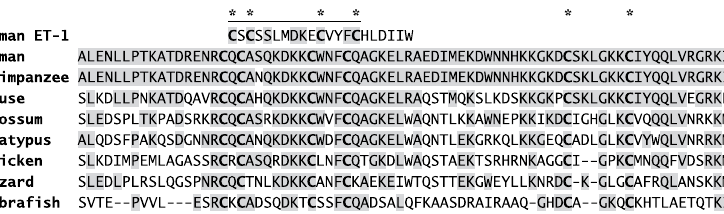
Figure 6. Inter species comparison of the conserved EDN1 gene derived endothelin-like domain peptide (ELDP) with ET-1. The single line indicates the endothelin-like domain, with alignment of human ELDP and ET-1. Shaded residues indicate homology with human ELDP, and asterisks indicate conserved Cys residues. Peptide sequences are from the UniProt KnowledgeBase: human ( Homo sapiens , P05305), chimpanzee ( Pan troglodytes , H2QSB1), mouse ( Mus musculus , P22387), opossum ( Monodelphis domestica , F6YR31), duckbill platypus ( Ornithorhynchus anatinus , F6WZM8), chicken ( Gallus gallus , F1NWA9), green anole lizard ( Anolis carolinensis , H9GDX1), and zebrafish ( Danio rerio , A5WW41).